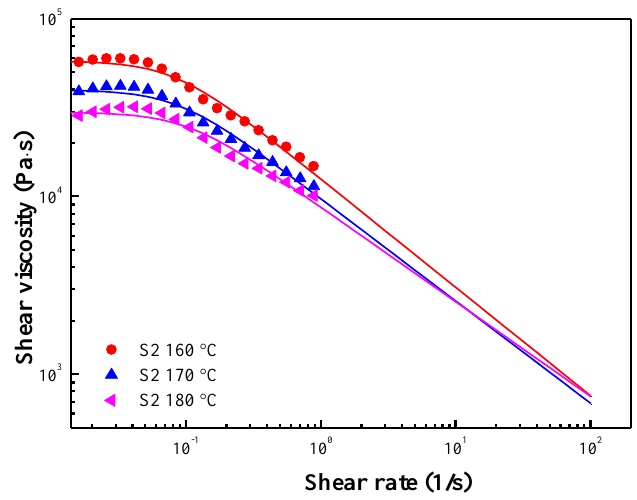
Figure 10. Shear viscosity as a function of shear rate for S2 at various temperatures. The solid lines were fitted by the Carreau model. Table 3. Fitting parameters of the Carreau model for S2 under various temperatures.